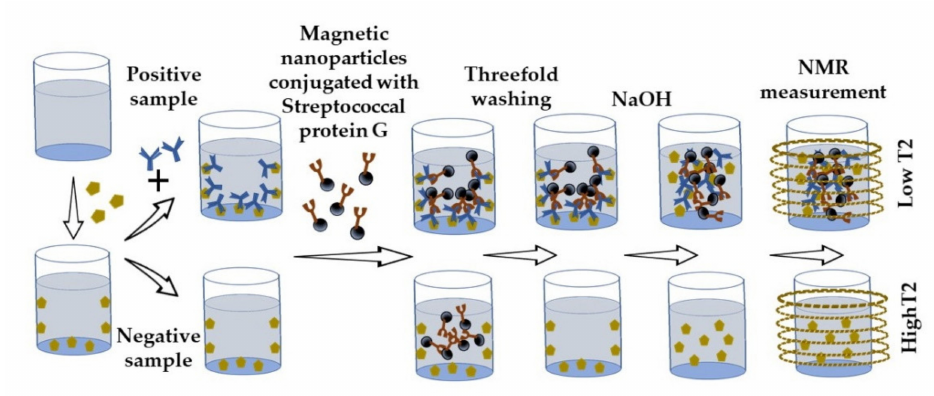
Figure 9. Nuclear magnetic resonance immunoassay based on the displacement of magnetic